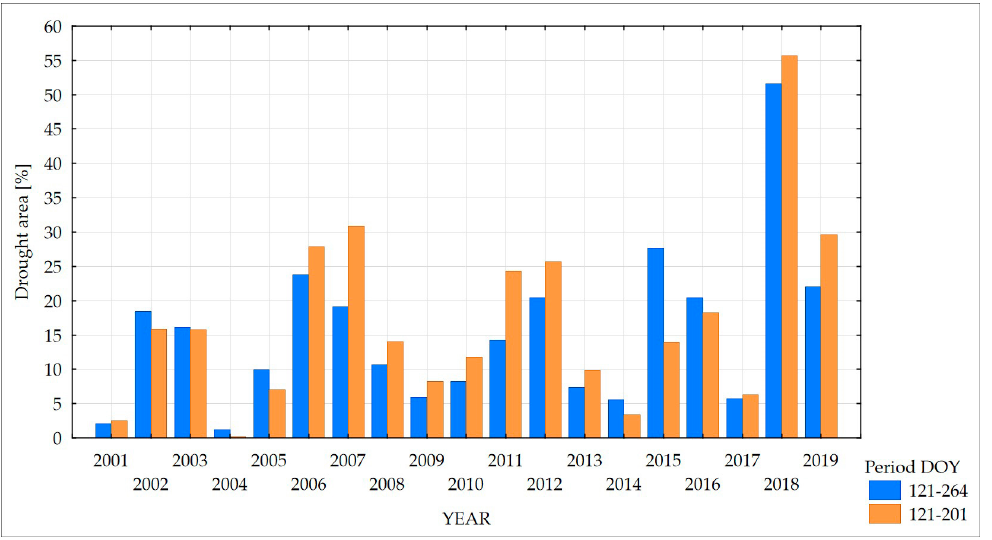
Figure 17. Percentage of drought area within the agricultural land of Poland (2001–2019).